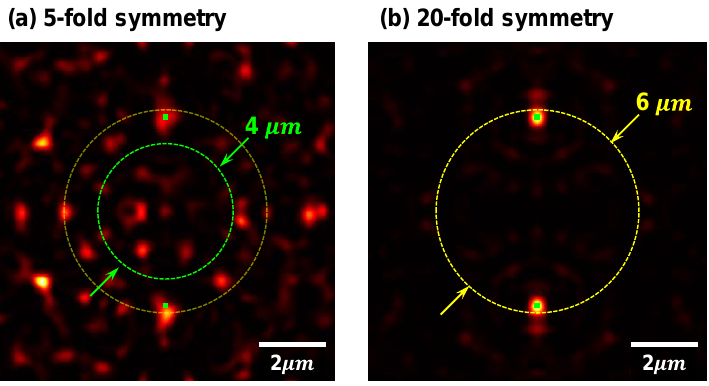
Figure 5. Comparison of an effective imaging area of nanohole array lenses: imaging of two separated incoherent point light sources. Plates ( a ) and ( b ) show a comparison of the effective imaging area using a 5-fold (a) and a 20-fold (b) symmetry quasi-periodic nanohole array lens, respectively. By separating the two incoherent point light sources with a separation of 6 μm, two imaged spots can still be revealed by using a 20-fold symmetry quasi-periodic nanohole array lens, indicating that a larger effective imaging area than that of a 5-fold symmetry quasi-periodic nanohole array